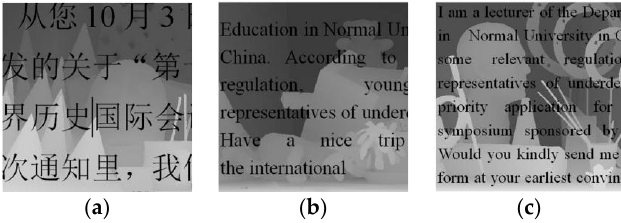
Figure 3. Experimental test images (2): ( a ) represents the Mask depth image; ( b ) represents the Teddy depth image; ( c ) represents the Art depth image.